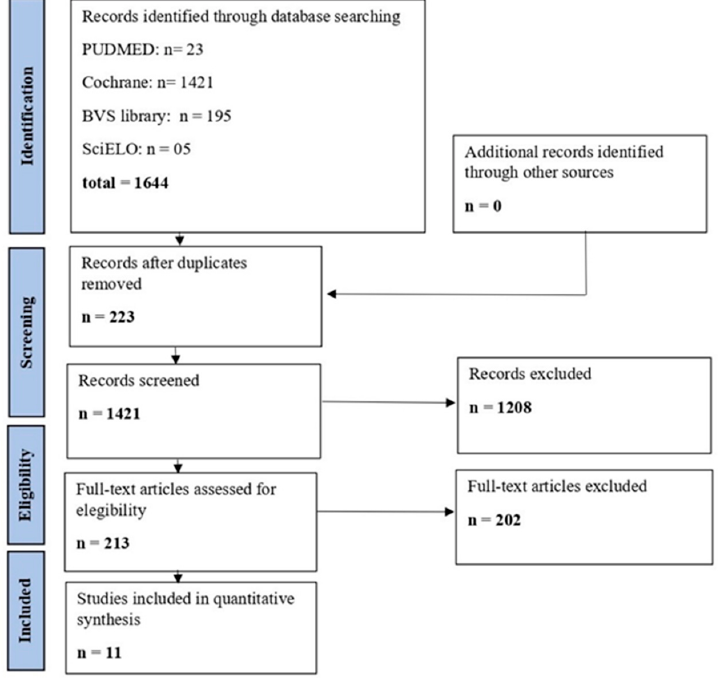
Figure 1. Preferred Reporting Items for Systematic Reviews and Meta-analyses flow diagram for study selection.